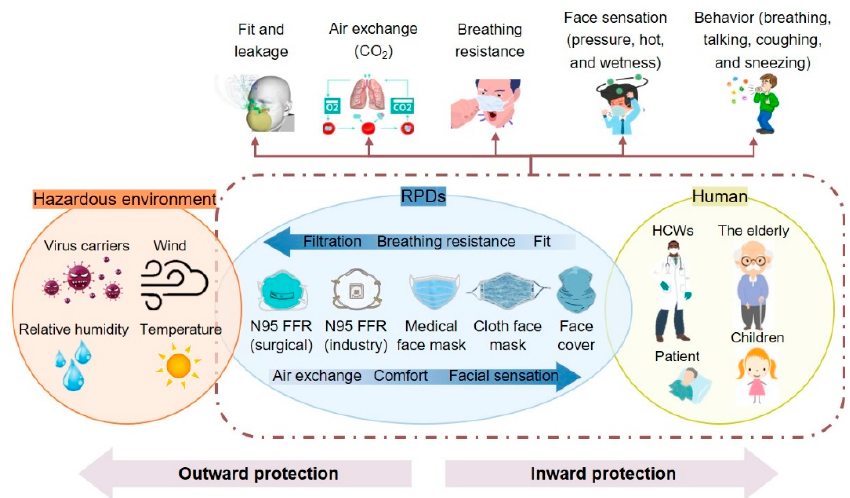
Figure 2. Interacting factors for different hazardous environments, respiratory protective devices (RPDs), and end users and their impact on protective performance and comfort.